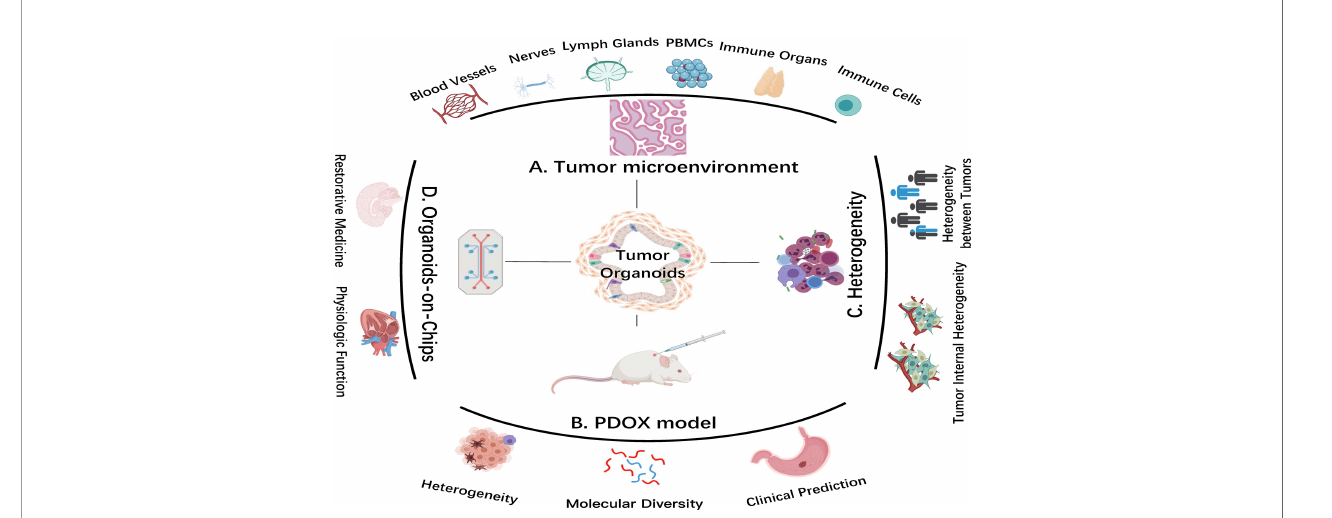
FIGURE 2 | Advanced organoid technology in cancer research. (A) Coculture system of tumor organoids with components of the tumor microenvironment (TME). (B) Patient-derived organoid xenograft (PDOX) model. The PDOX model indicates tumor heterogeneity and molecular diversity and predicts clinical treatment in vivo . (C) Tumor organoids better re fl ect tumor heterogeneity. (D) Organoids-on-Chips system. This system combines organoid and tissue engineering to highly replicate physiological function in vitro and to facilitate regenerative medical development. Images are adapted from Servier Medical Art